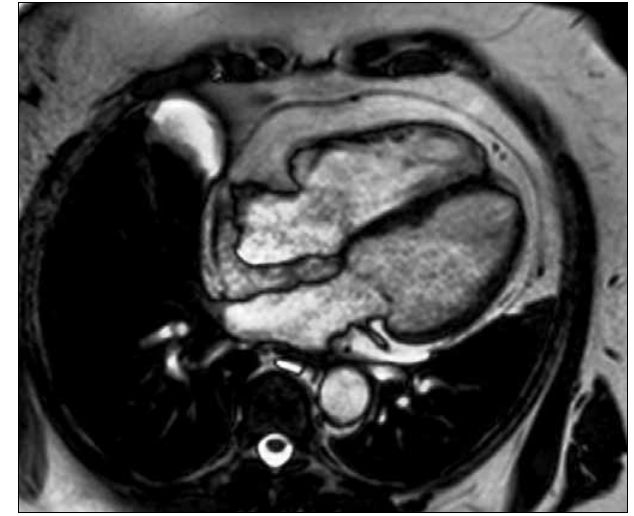
Fig. 5. Four chamber bright blood cine image. BTFE TR=3.4, TE=1.7,